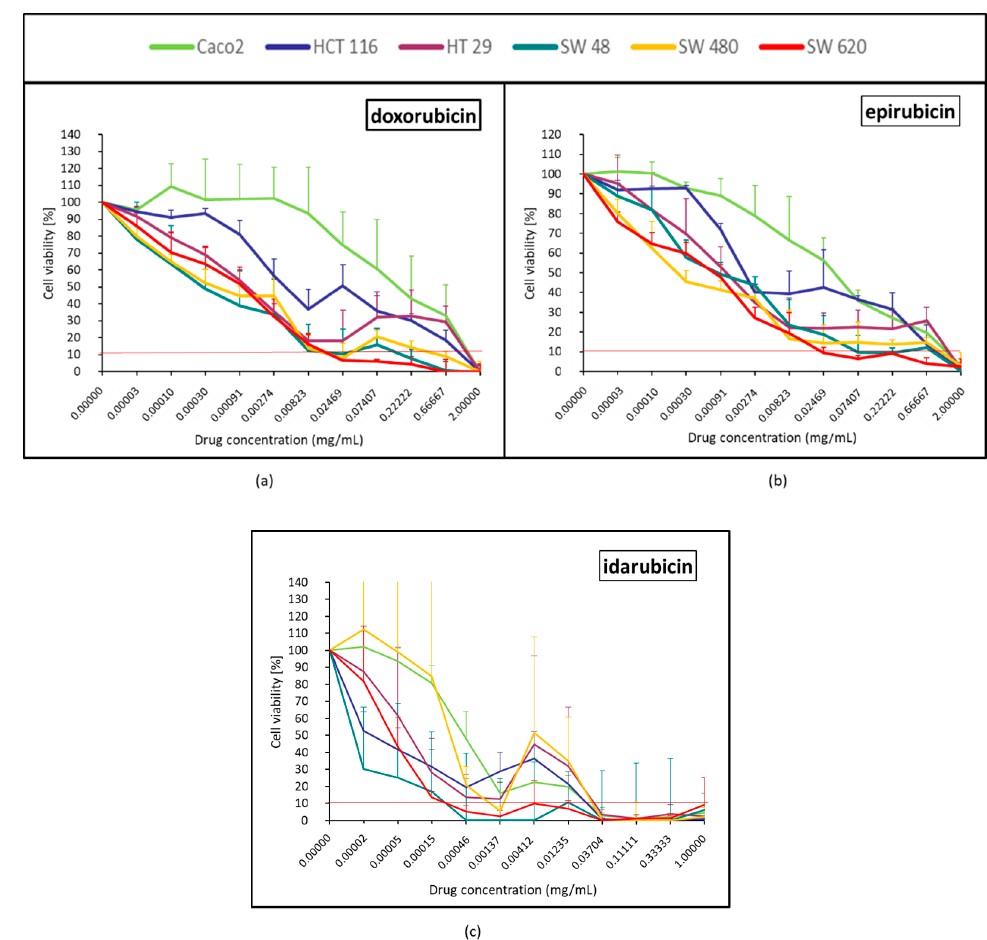
Figure 1. Colorectal cancer cell line viability curves (mean ± standard deviation) after a 30 min contact time with the 3 anthracyclines: doxorubicin ( a ), epirubicin ( b ), and idarubicin ( c ). The horizontal red line represents 10% of cell viability. The results are presented after normalization with the control cells (untreated condition).